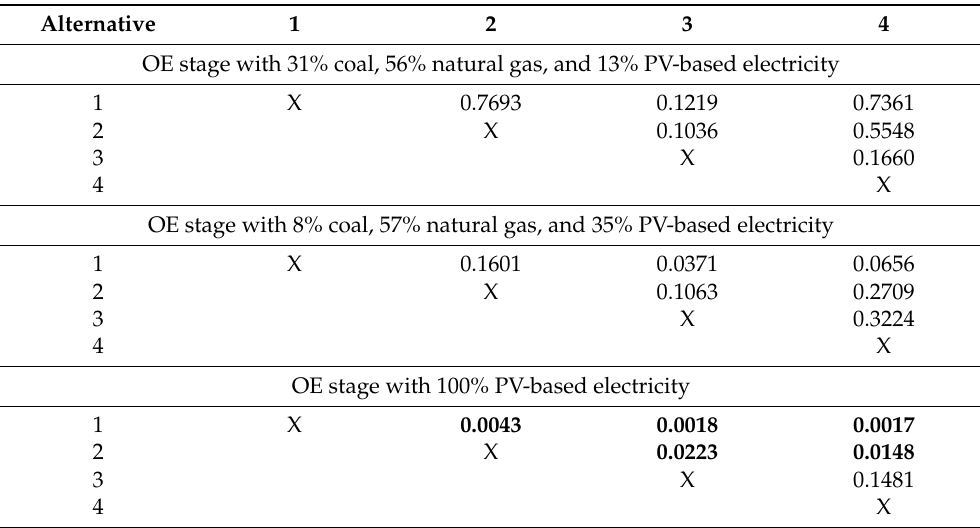
Table 8. P&R + OE stages: p -values of paired differences of CB MinWin (1), CB MaxWin (2), AAB MinWin (3), and AAB MaxWin